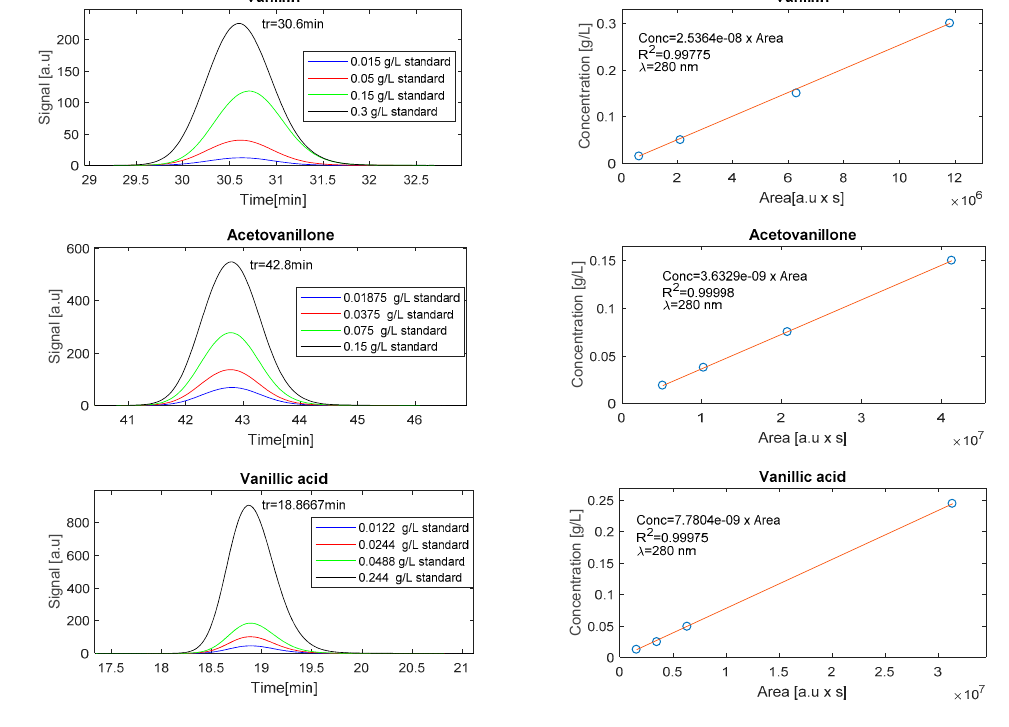
Figure A1. Calibration curves of some monomers.